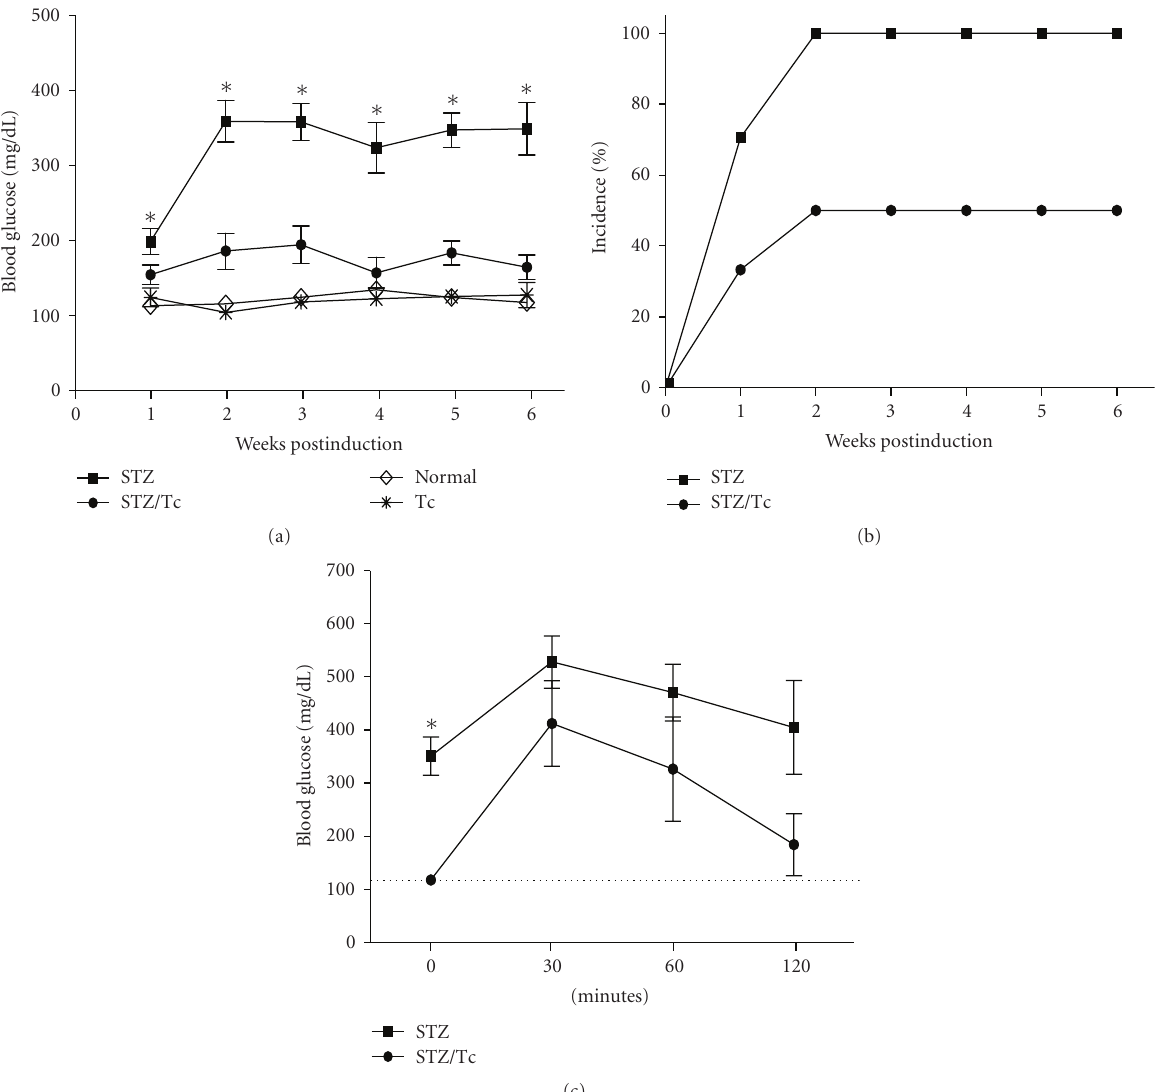
the islet histopathology from T. crassiceps -infected mice